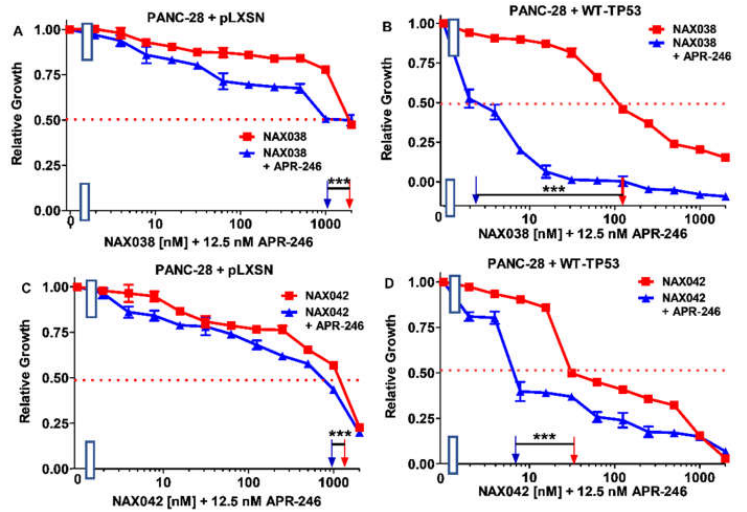
Figure 13. APR-246 enhances the effects of NAX038 and NAX043 greater when WT-TP53 is present in PANC-28 cells than when WT-TP53 is absent. Panel ( A ) PANC-28 + pLXSN cells treated with different concentrations of NAX038 (red squares) or with different concentrations of NAX038 and a low dose of APR-246 (blue triangles). Panel ( B ) PANC-28 + WT-TP53 cells treated with different concentrations of NAX038 (red squares) or with different concentrations of NAX038 and a low dose of APR-246 (blue triangles). Panel ( C ) PANC-28 + pLXSN cells treated with different concentration of NAX042 (red squares) or with different concentrations of NAX042 and a low dose of APR-246 (blue triangles). Panel ( D ) PANC-28 + WT-TP53 cells treated with different concentrations of NAX042 (red squares) or with different concentrations of NAX042 and a low dose of APR-246 (blue triangles). The measurements were repeated 3 times, and similar results were observed. *** = p < 0.0001.